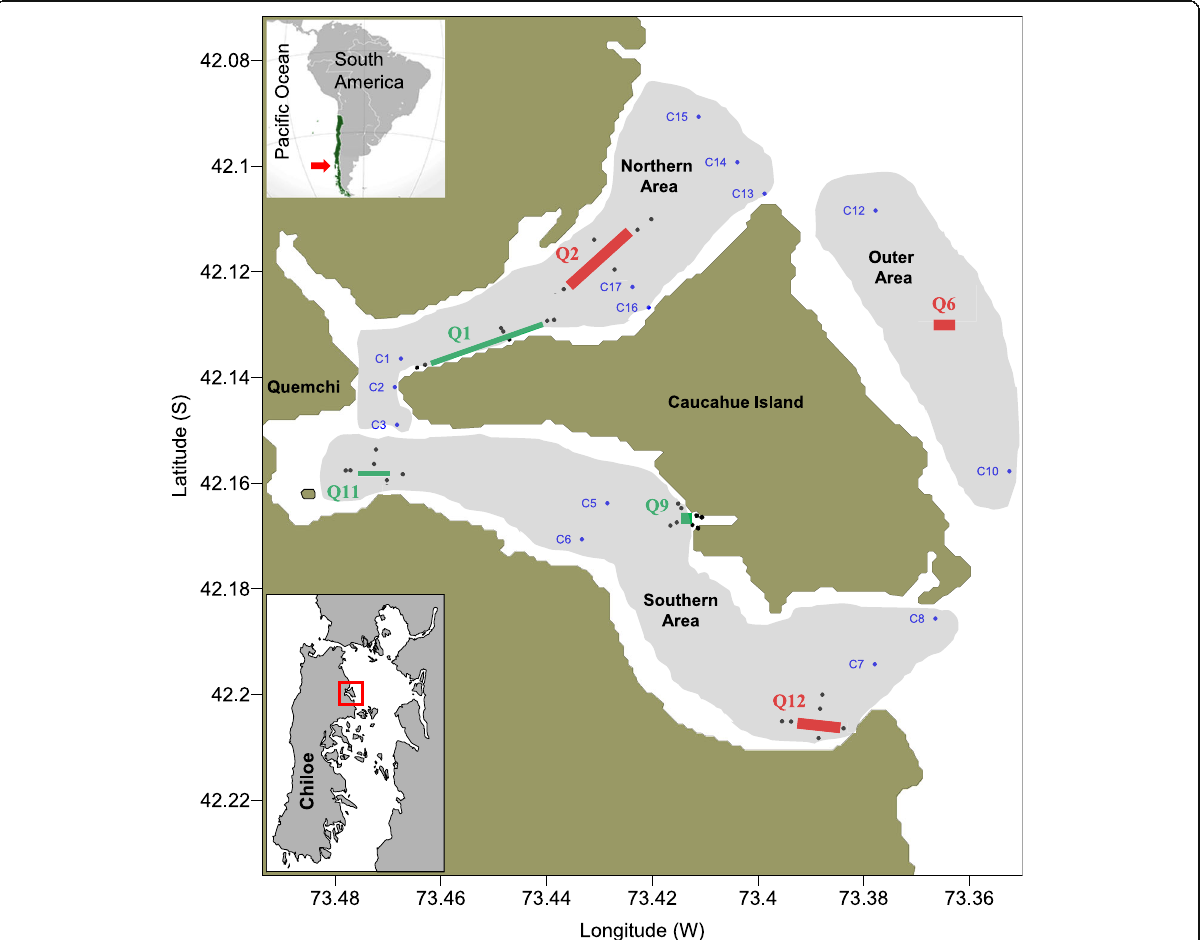
Fig. 1 Caucahue Channel showing sampling sites. Q sites are near active aquaculture centers (green area with black dots = mussel farm, red area with black dots = salmon farm). Blue dots (C sites) represent reference sites far from active aquaculture centers. Grey zones correspond to northern, southern and outer areas of the